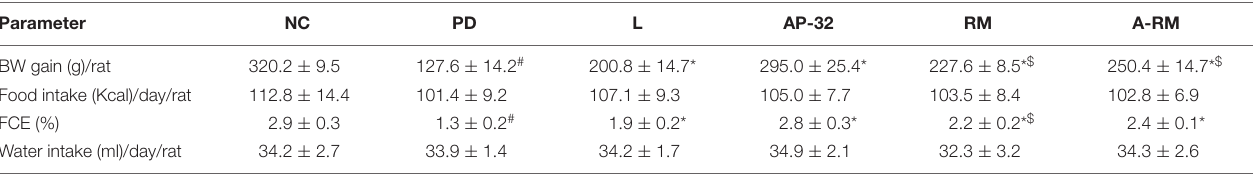
TABLE 3 | The effect of AP-32, RM, and A-RM on BW gain, food intake, food conversion efficiency, and water intake in 6-OHDA-induced PD rats.